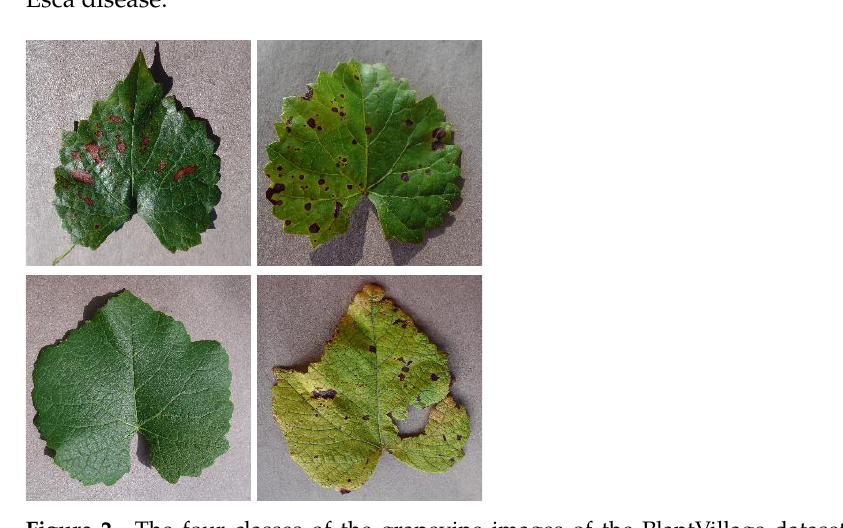
Figure 2. The four classes of the grapevine images of the PlantVillage dataset: black measles ( upper left ), black rot ( upper right ), healthy ( down left ), leaf blight ( down right